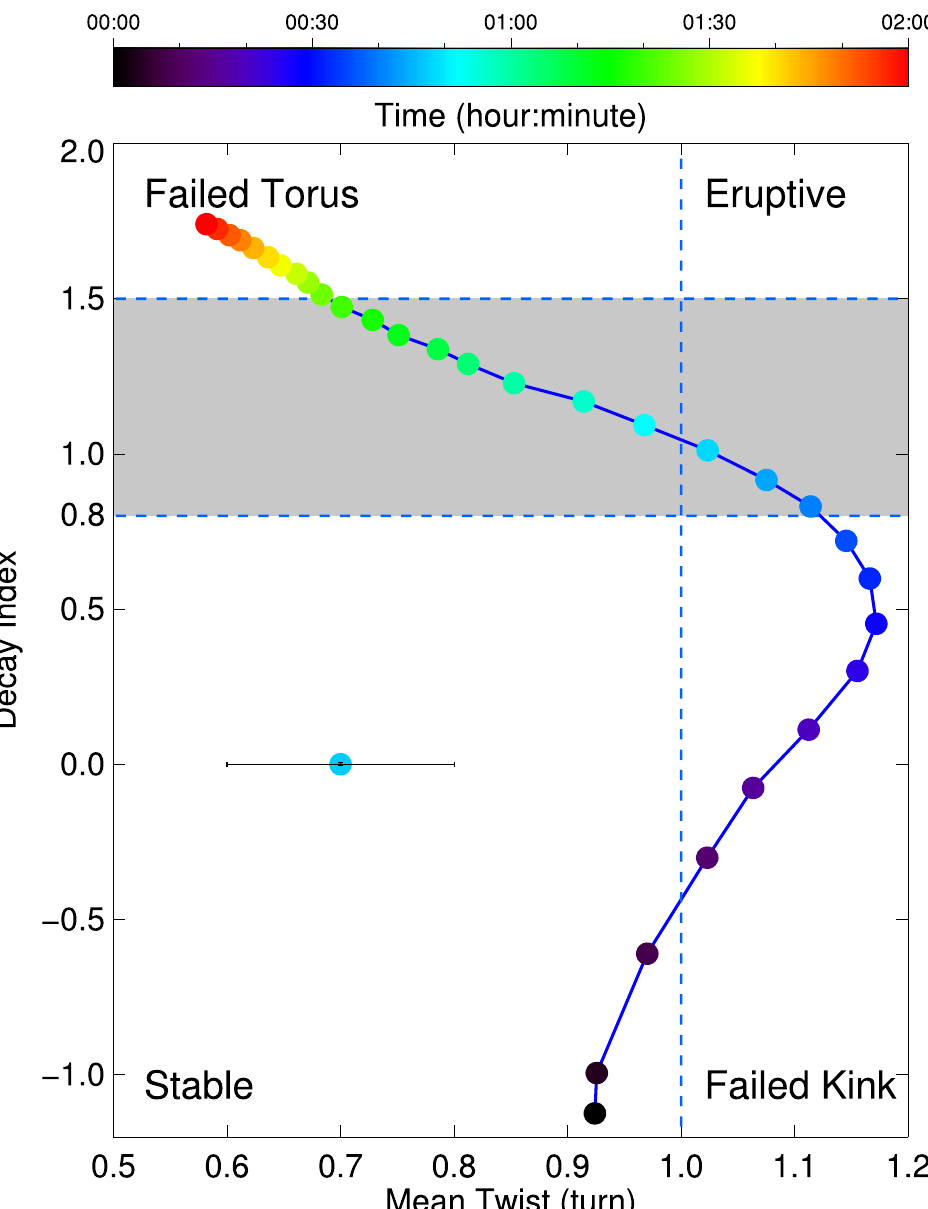
Fig. 8 Phase diagram showing the temporal evolution of the absolute value of the mean twist of the MFR versus the decay index of the external poloidal magnetic fi eld. The X -axis represents the twist number T measured in turns, while the Y -axis represents the decay index, which are considered as basic parameters for helical kink instability and torus instability, respectively. The whole region is divided into four distinct parameter quadrants by the critical values for two instabilities. The shaded region refers to the range (the lower and upper limits) of the critical value for torus instability, as derived from theories 21 – 24 , observations 27,28,48 , or experiments 29,30 . The error bar shown in the bottom left part of the panel refers to the uncertainty of the mean twist for a typical